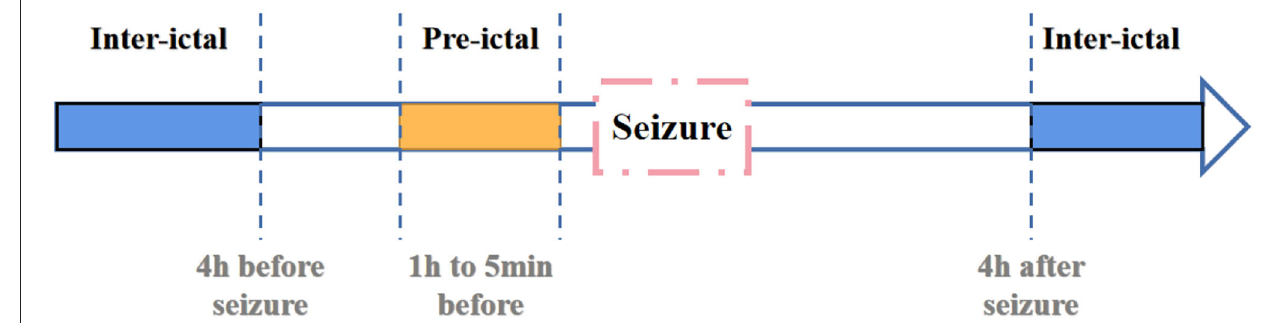
FIGURE 6 | According to actual seizure process, EEG is divided into different